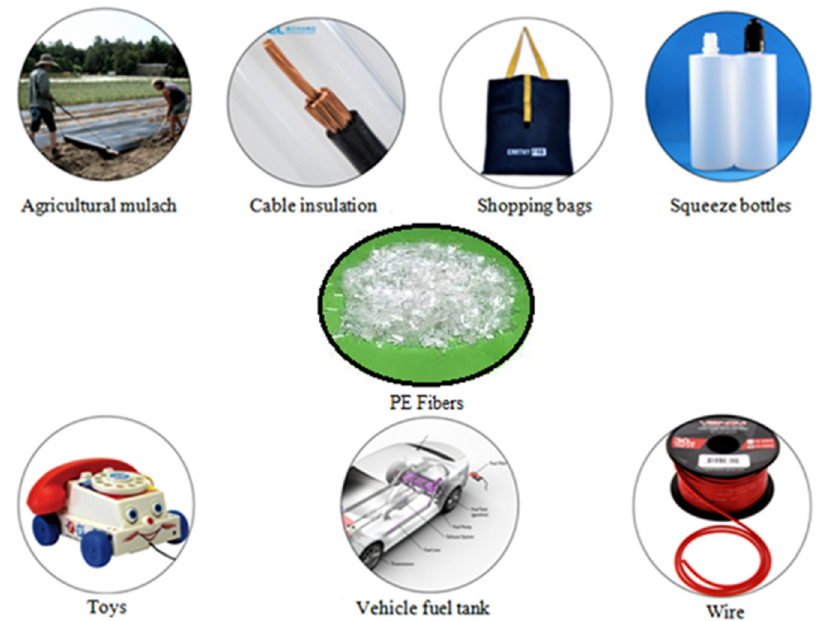
Figure 5. Various branches of polyethylene fiber